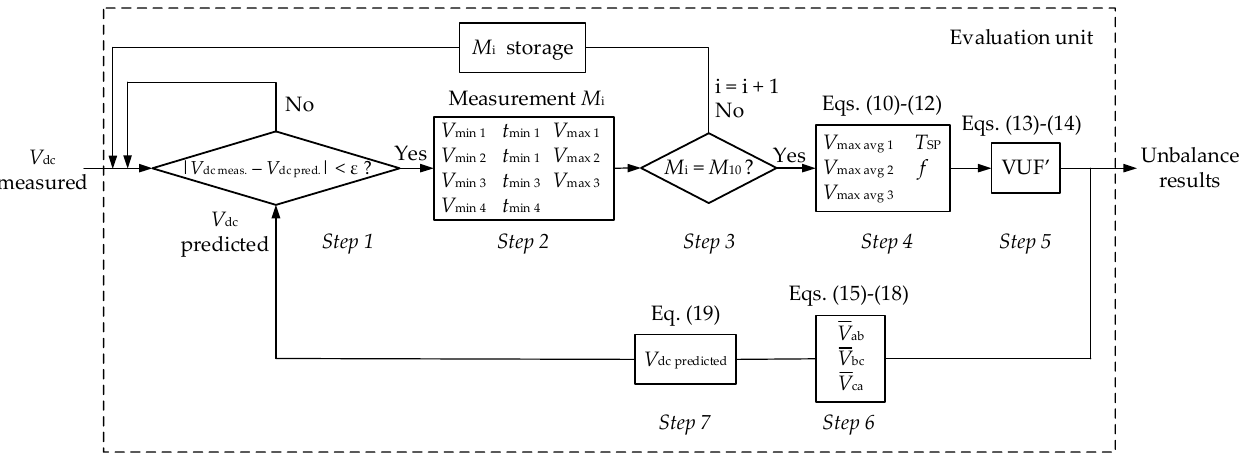
Figure 2. Flowchart with the proposed methodology to calculate the VUF (note that calculations are made within the evaluation unit of the proposed smart sensor, as shown in Figure 1).